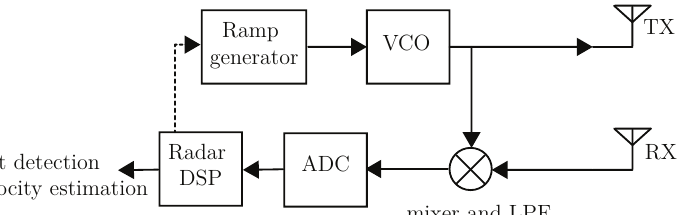
Figure 1. Architecture of an Frequency Modulated Continuous Wave (FMCW)